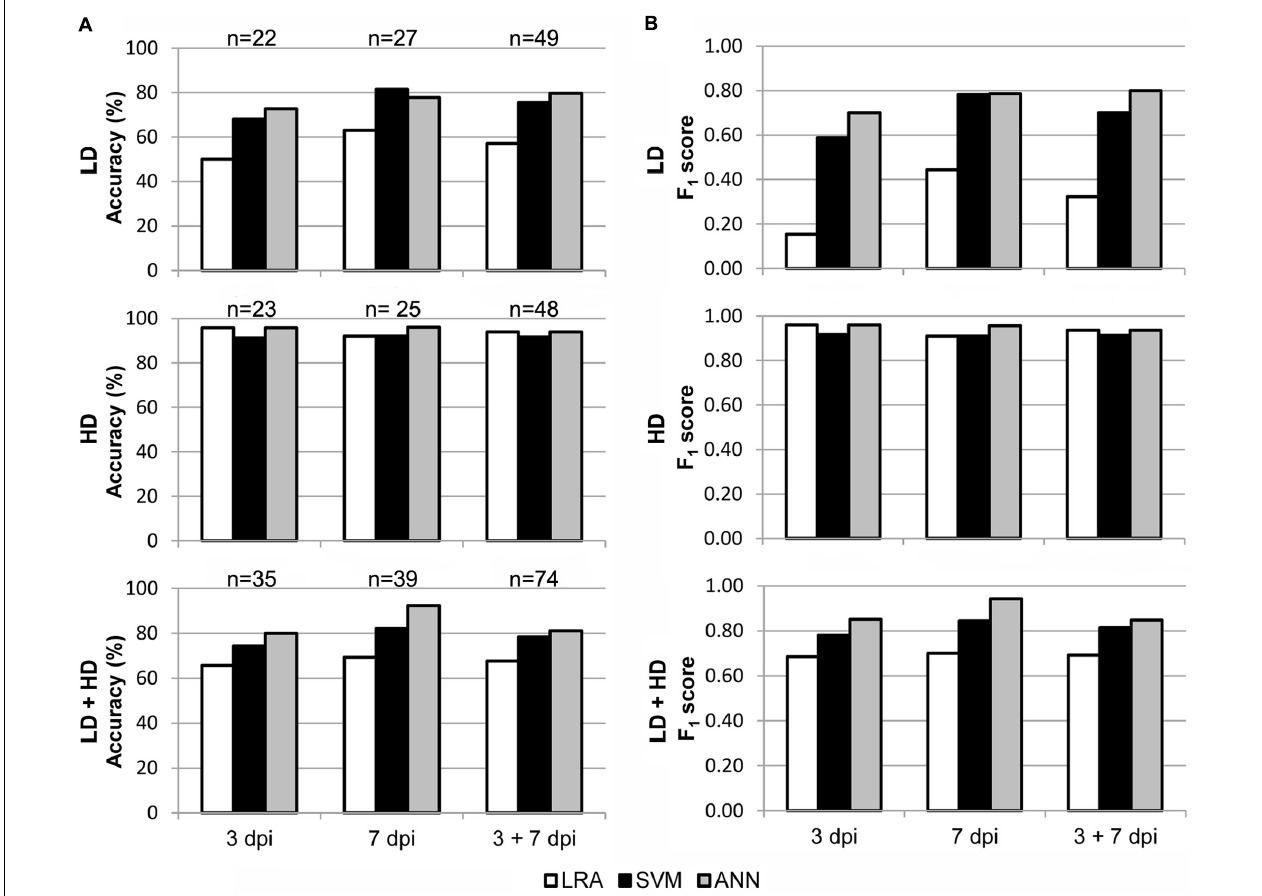
FIGURE 5 | Results of the validation of the I area models used to classify whole leaves as healthy and D. dadantii -infected. Classifiers were trained with data from all available I areas and tested on the data set for whole leaves. (A) Accuracy of the models. (B) F 1 score of the classifiers. dpi, days post-inoculation; LD and HD, low and high bacterial dose (10 4 and 10 6 colony forming units ml − 1 , respectively). n test is specified in (A)